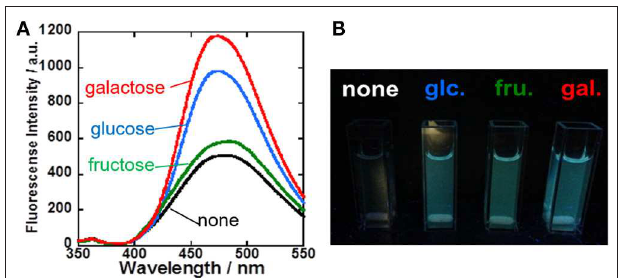
FIGURE 3 | Estimated structure of 1 / γ -CyD complex. cavity than β -CyD, and so probe 1 and γ -CyD formed 2:1